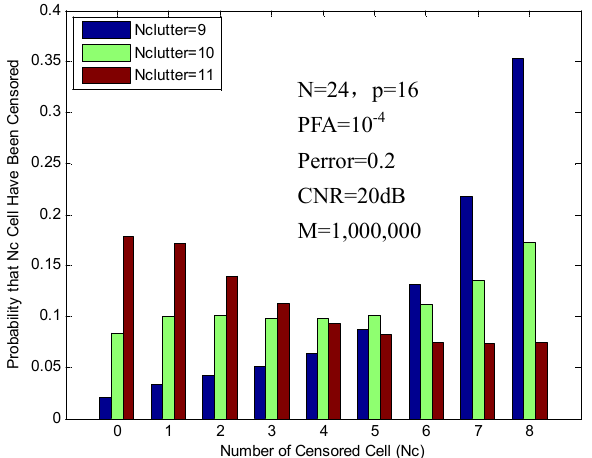
Figure 10. Probability of censoring in the clutter edge environment (9, 10 and 11 clutter